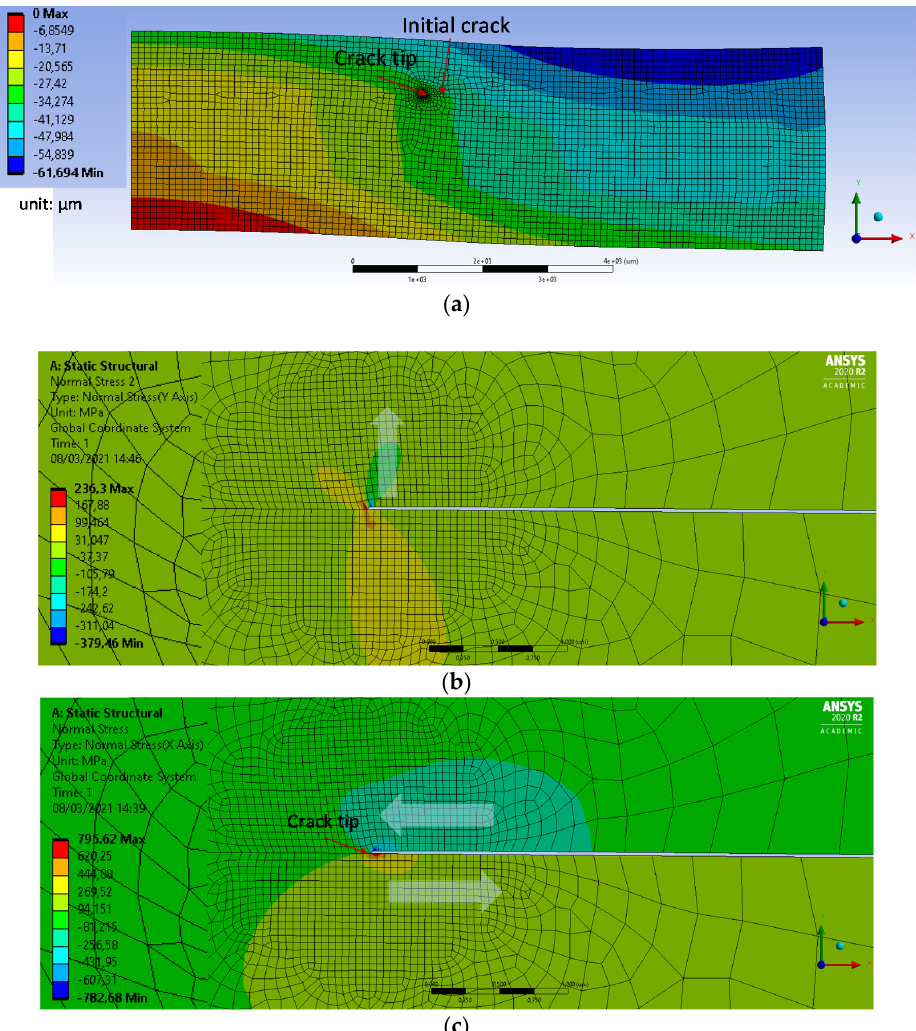
Figure 6. Package deformation and corresponding fracture mode at crack tip. ( a ) Deformation of the package; ( b ) Opening mode at crack tip; ( c ) Shear mode at crack tip. Table 3. Material properties and model dimension.